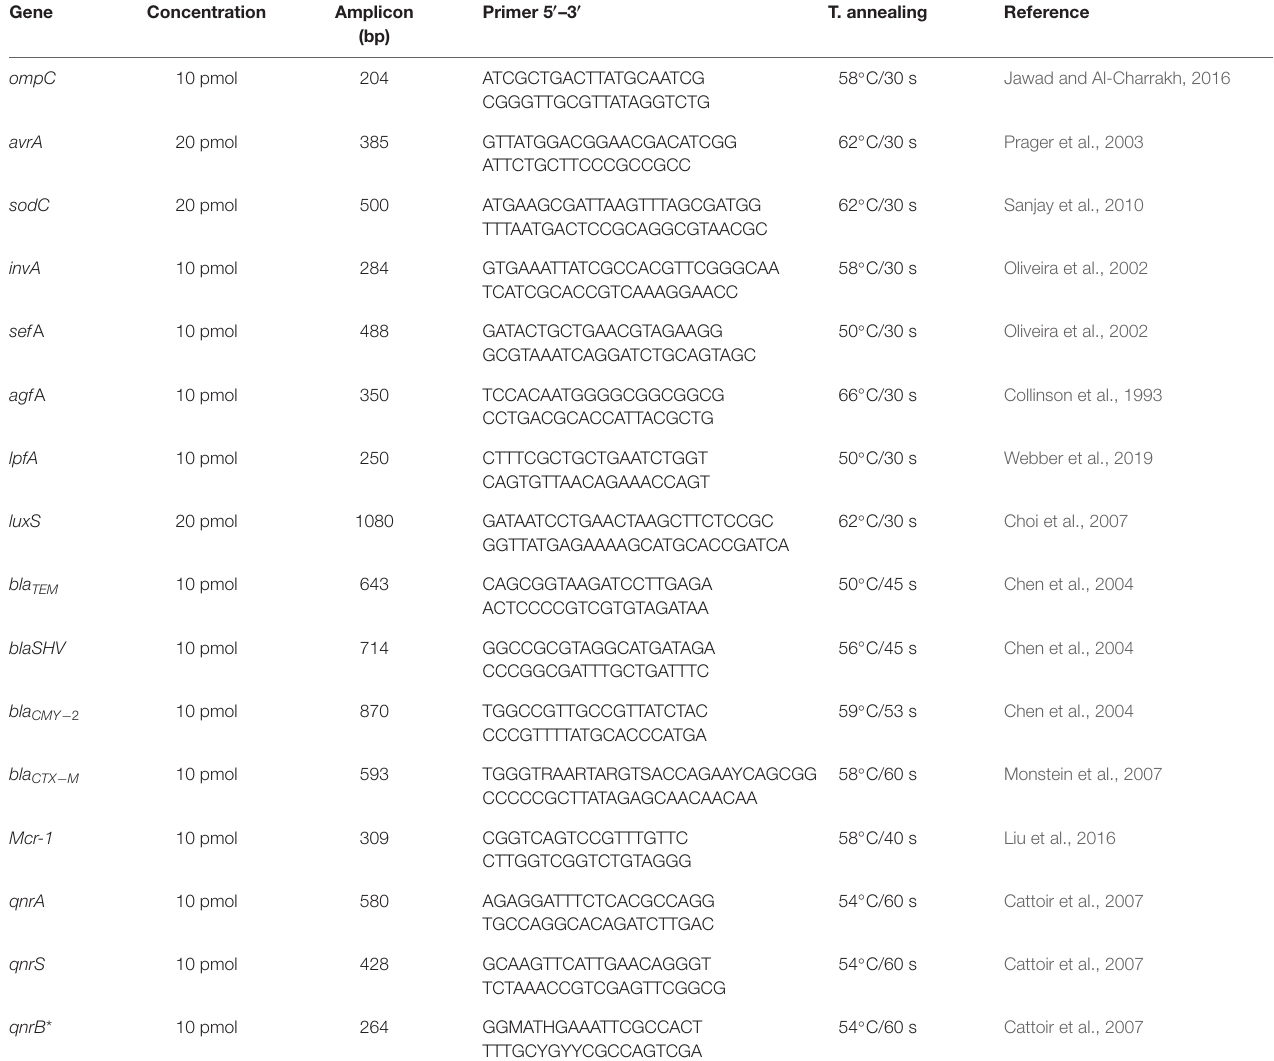
TABLE 2 | Primers used to identify specific genes in S H